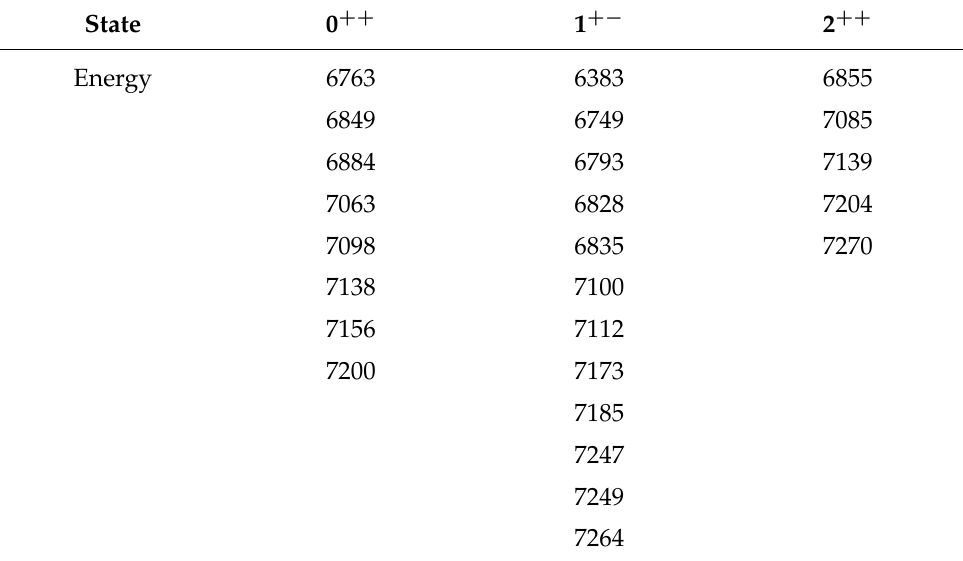
Table 6. The resonance states with quantum numbers J PC = 0 ++ ,1 + − ,2 ++ for the cc ¯ c ¯ c system (unit: MeV). State 0 ++ 1 + − 2